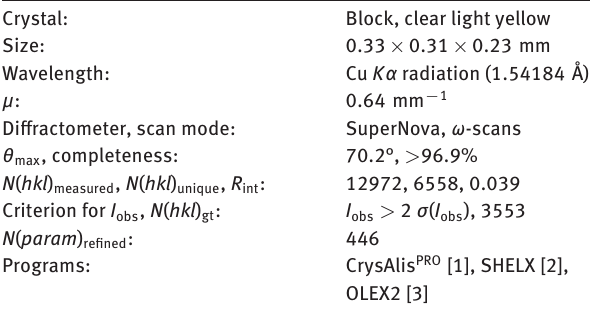
Table 1: Data collection and